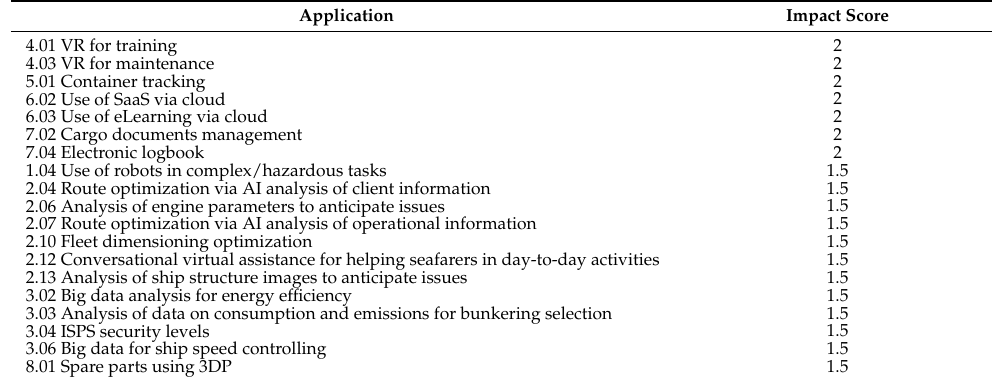
Table 6. Top applications on Time performance dimension.